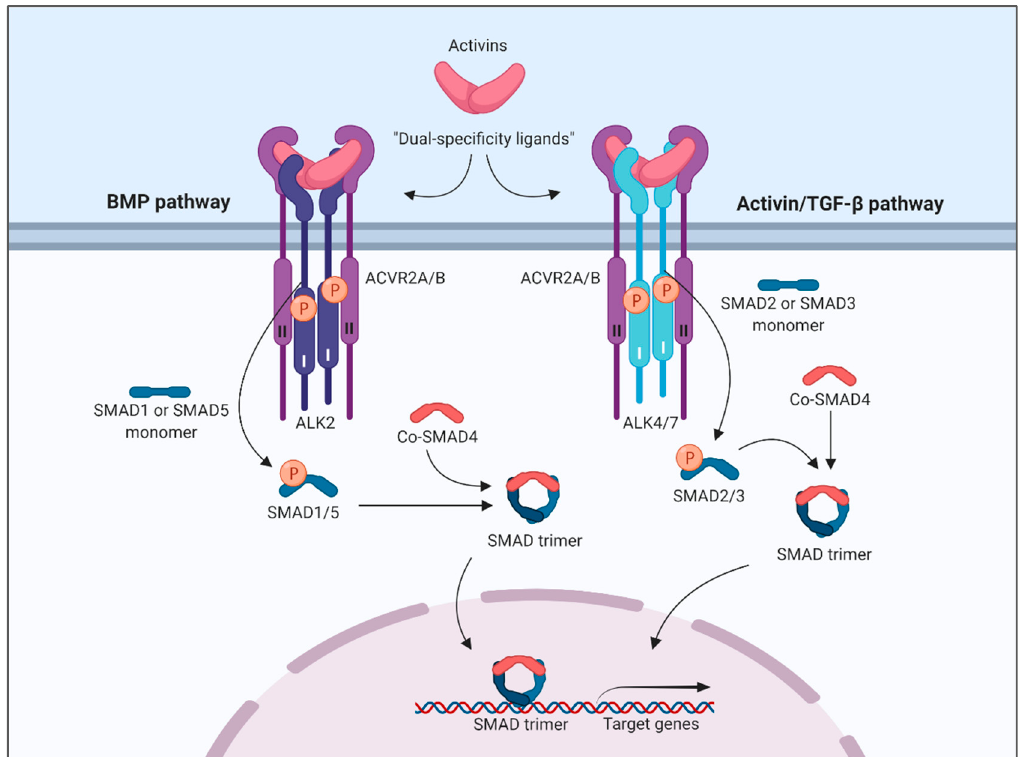
Figure 7. Proposed dual specificity of activins. Activins belong to the activin / TGF- β branch of the TGF- β family, but share the type II receptors ACVR2A and ACVR2B, and in some cases, BMPR2, with BMPs. The activins can therefore compete with BMPs for use of type II receptors. Usually, the type I receptor in the complex is either ALK4 or ALK7, and activation of these, lead to SMAD2 / 3 phosphorylation. Interestingly, activins may also form ligand–receptor complexes where the type I receptor is the BMP receptor ALK2. Activation of ALK2 leads to SMAD1 / 5 phosphorylation. The complex of activins, type II receptors and ALK2 can either be non-signaling (no SMAD1 / 5 phosphorylation), induce a weak activation of SMAD1 / 5, or potently activate SMAD1 / 5, depending on which activin is in the complex and the cellular context. This image was created with Biorender.com.